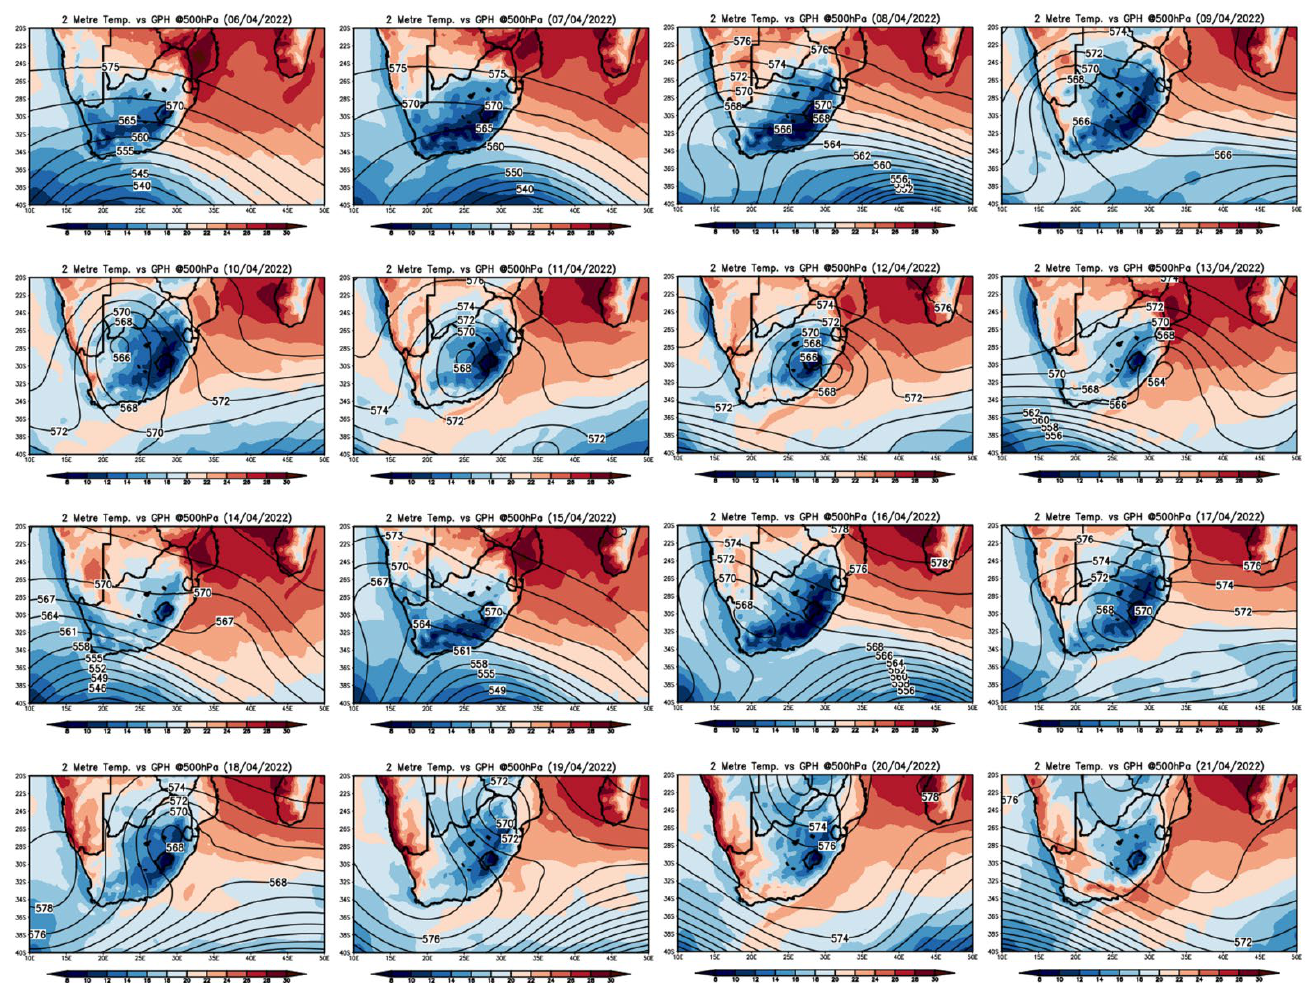
Figure 6. ERA5 geopotential heights (m) at 500 hPa and SAWS maximum temperature (°C) rainfall over South Africa during the period 6–21 April 2022.